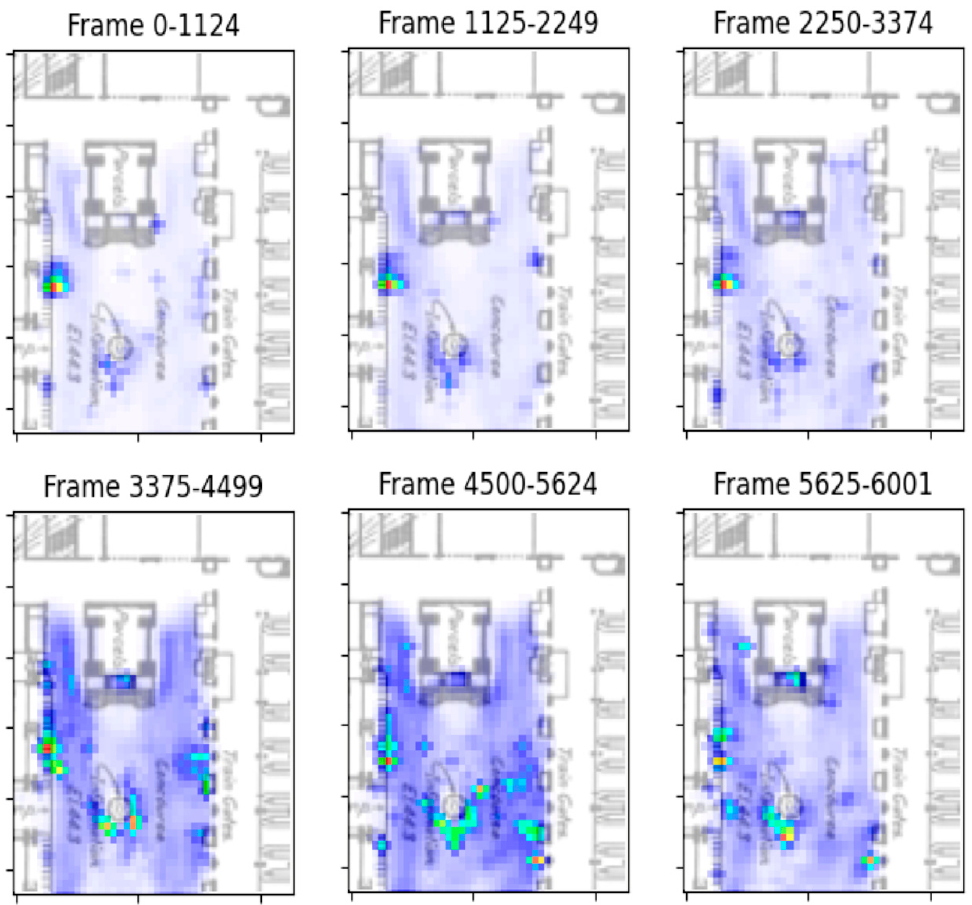
Figure 8. Heatmap visualization of crowd flow density over time in 15-min (1125–frame at 1.25 FPS) intervals. The density map colors range from blue to red with red being the highest density.